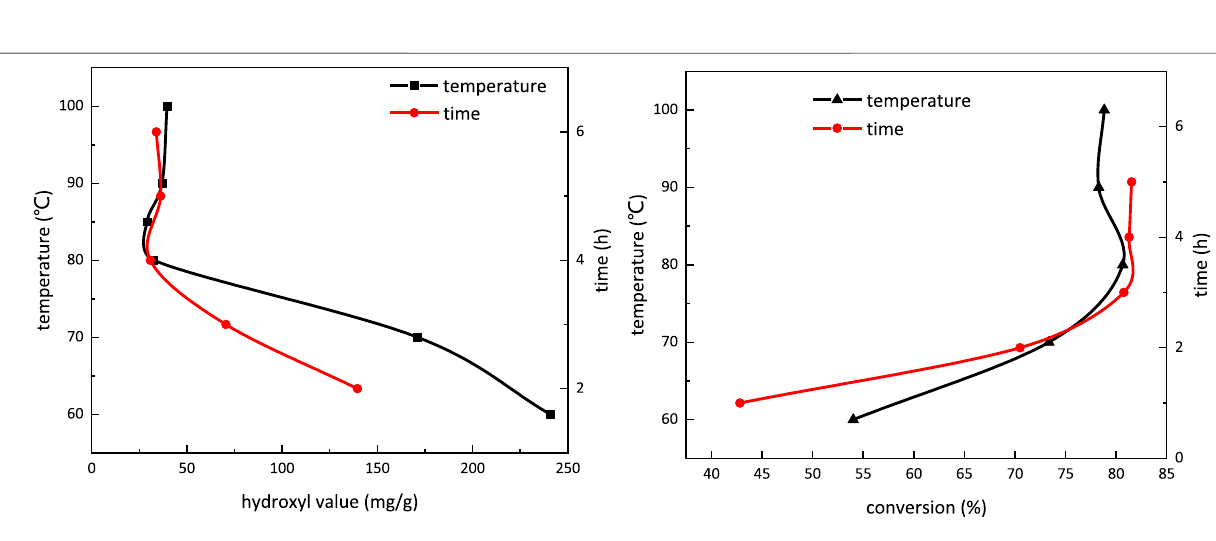
Frontiers in Chemistry |